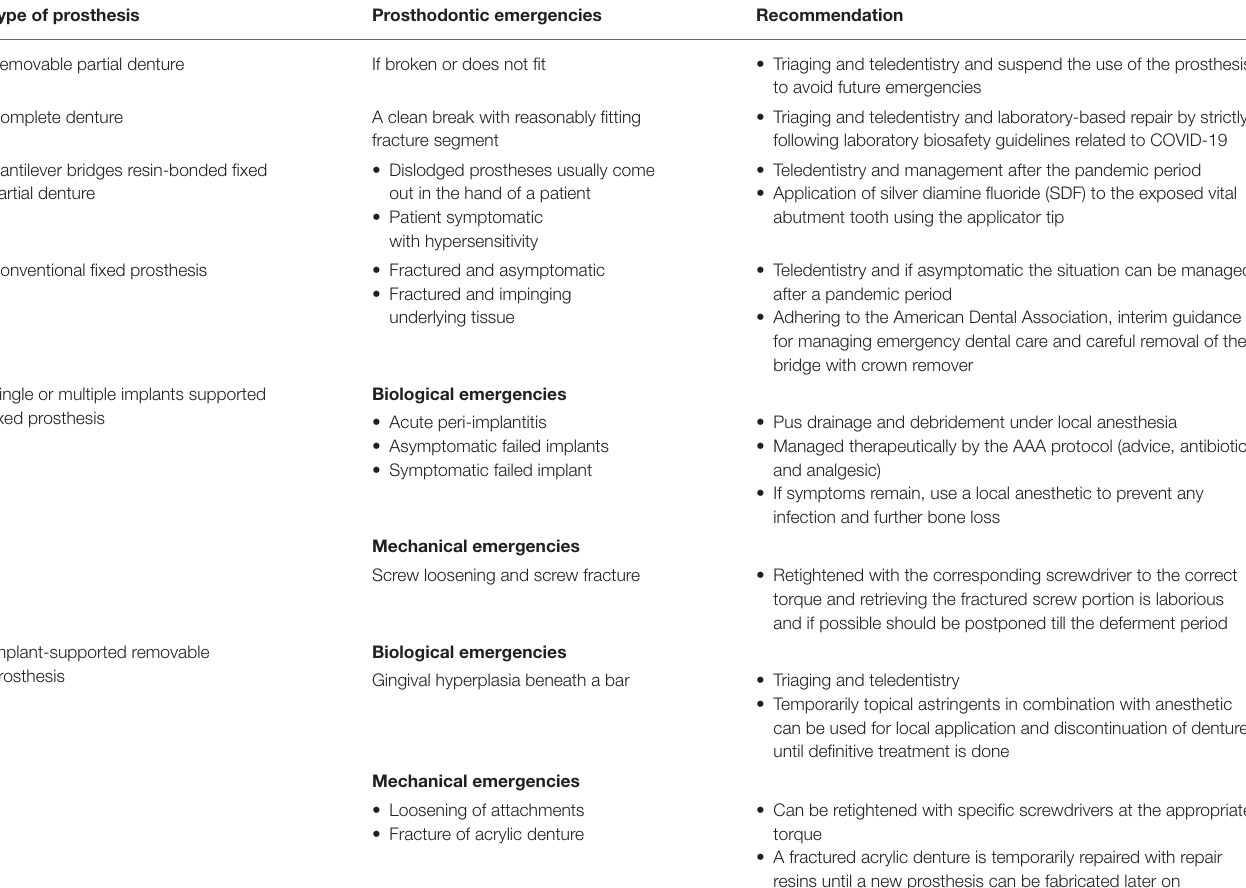
TABLE 1 | Prosthodontic emergency scenarios in the geriatric population and recommendations. Type of